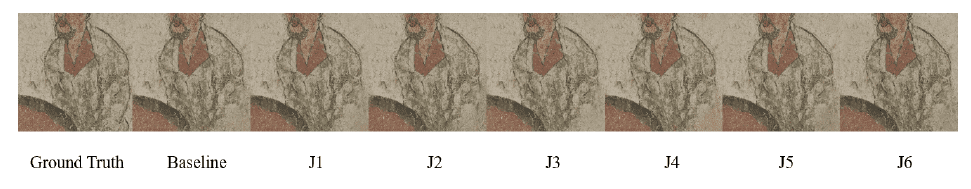
Figure 12. Subjective results for different sequences of modules. By comparison, the best results are obtained with J2, which is more similar to the image ground truth.